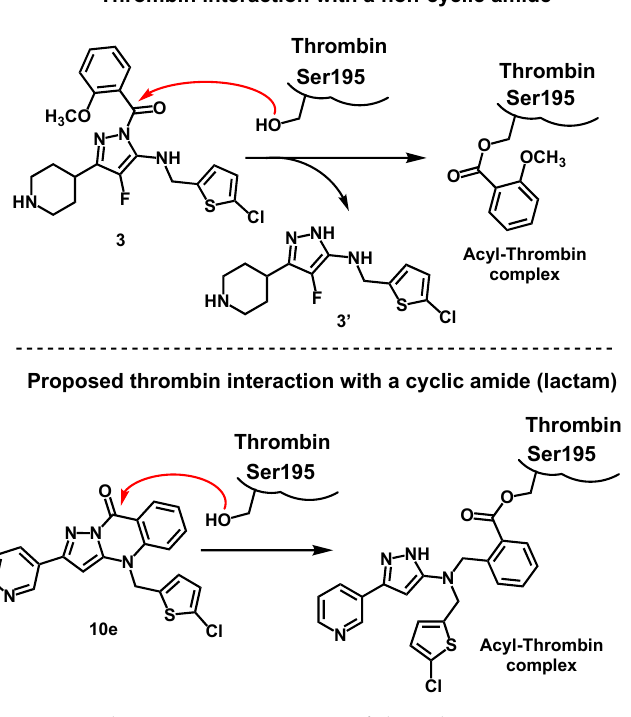
Figure 2. Schematic representation of thrombin’s Ser195 interaction with acylated 1 H -pyrazol-5- amine 3 ( top ) vs. proposed interaction of thrombin with cyclic amides 10e ( bottom ).